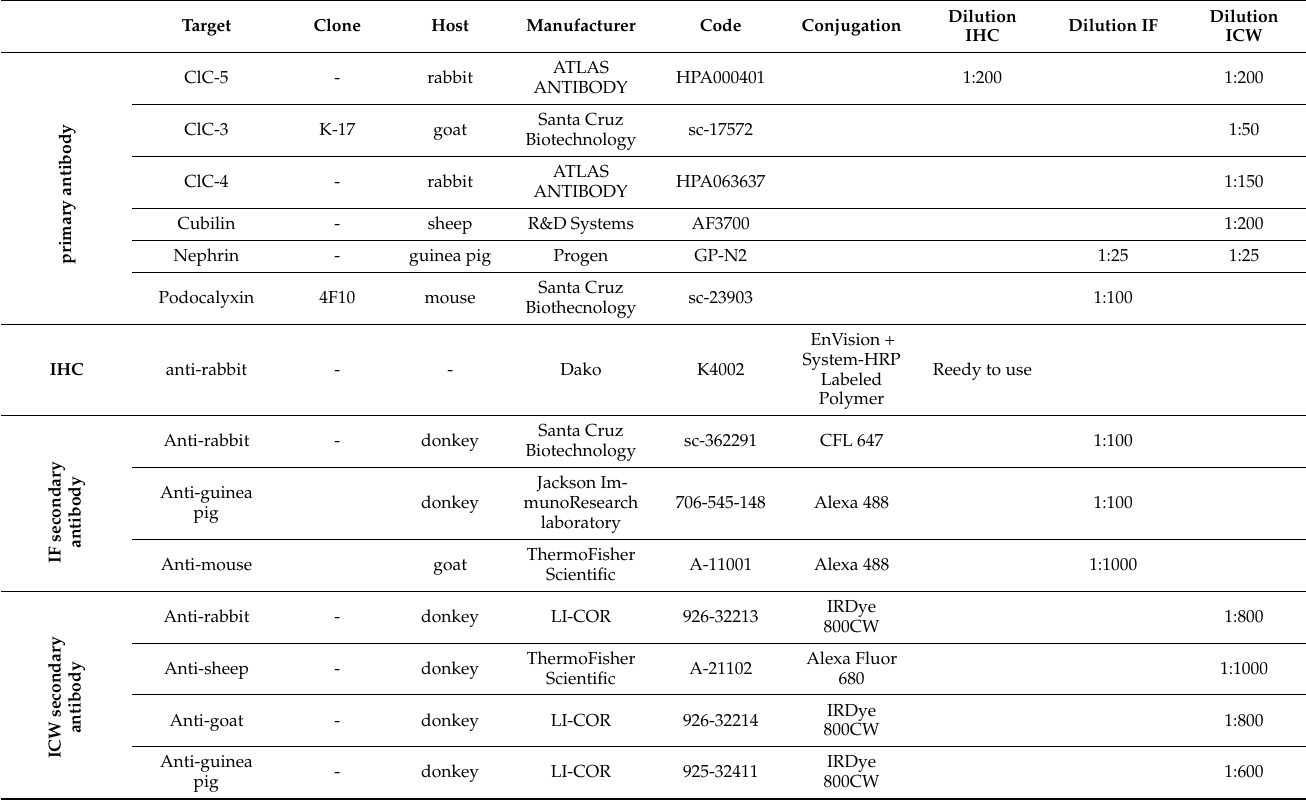
Table 2. Antibodies used in IHC, IF, and ICW